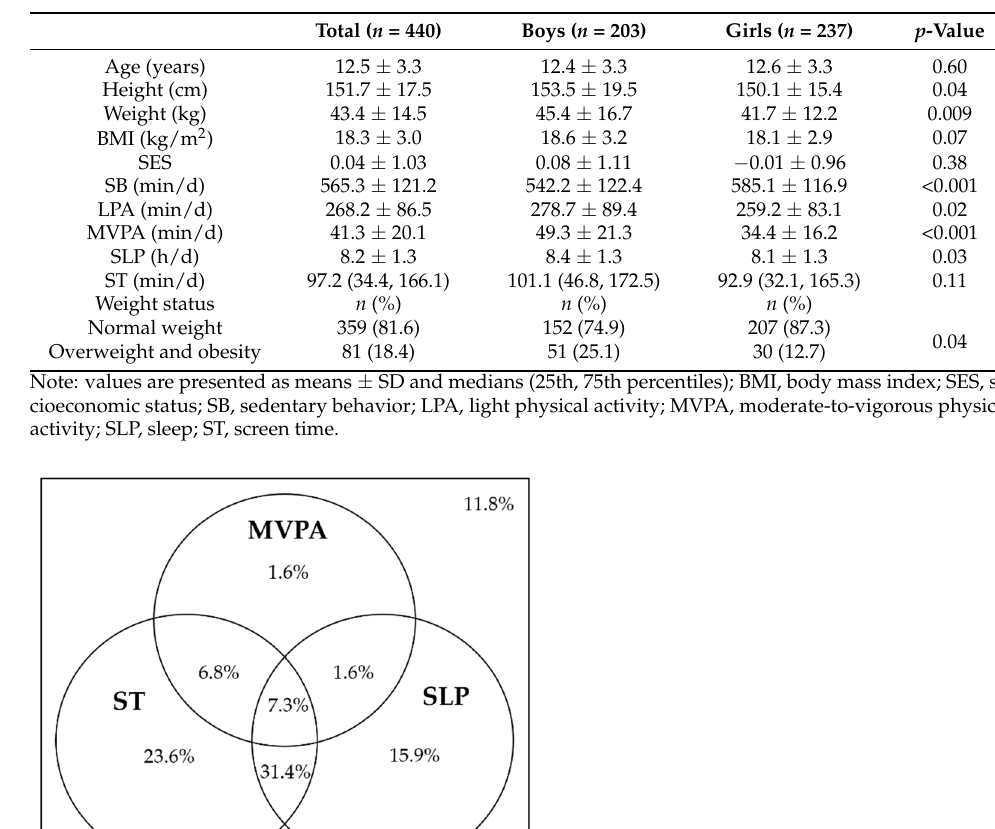
Table 1. Descriptive characteristics of participants.